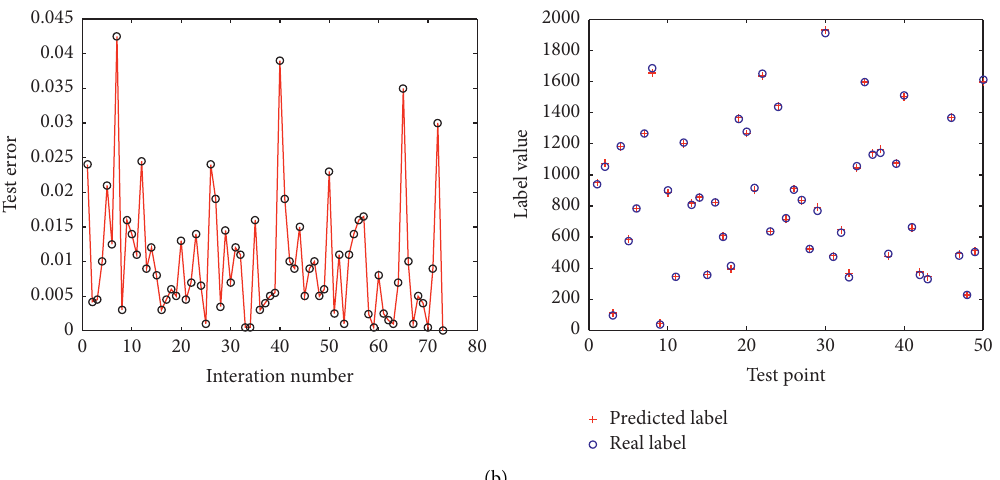
Figure 3: Error and fitting curves of the four benchmark functions. (a) Sphere function. (A) Error curve. (B) Fitting figure. (b) Sum squares function. (A) Error curve. (B) Fitting figure. (c) Rastrigin function. (A) Error curve. (B) Fitting figure. (d) Schwefel function. (A) Error curve. (B) Fitting figure.